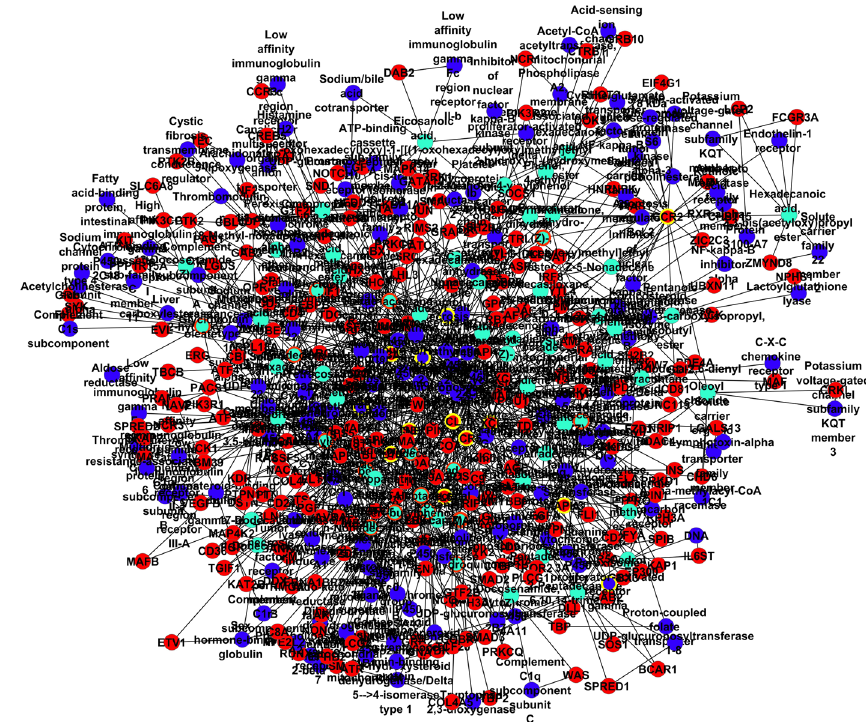
Fig. 5 Compositive compound-putative target-RA known target network. Edges: interactions among compositive compounds, putative targets and known RA therapeutic targets. Green round nodes: RP–RB compositive compounds; red round nodes: putative targets; blue round nodes: RA known therapeutic targets. Nodes with yellow are major components with corresponding high weighted centrality